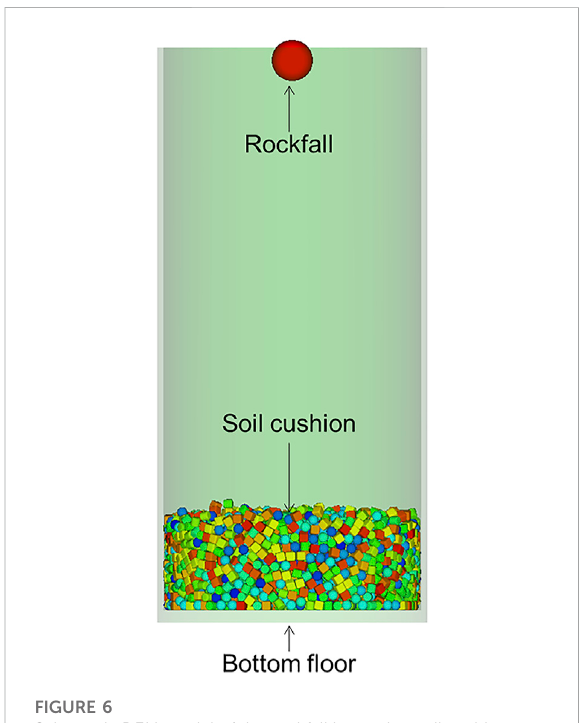
FIGURE 6 Schematic DEM model of the rockfall impacting soil cushion layer.